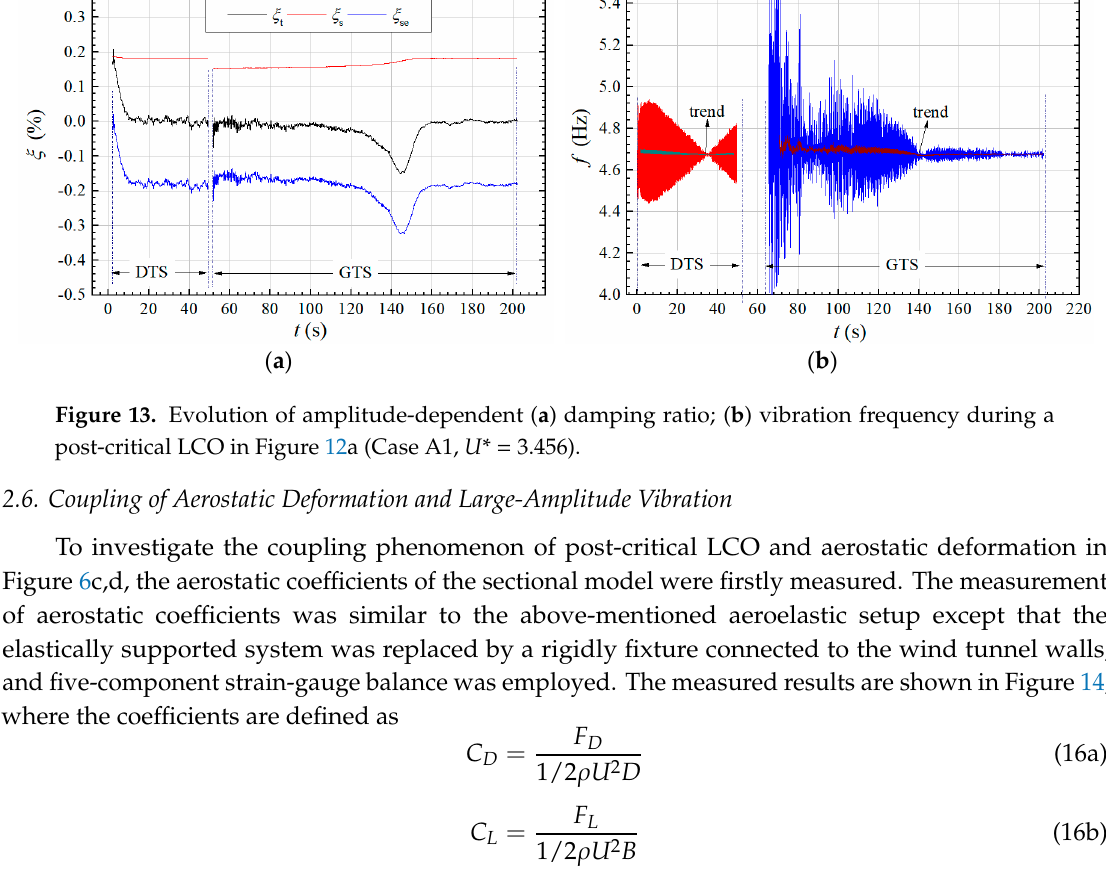
Figure 12. Typical post-critical LCO under different initial perturbations (Case A1, U * = 3.456). ( a ) Time history; ( b ) phase diagram.